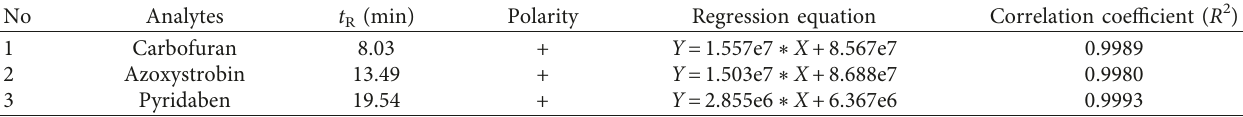
Table 4: Calibration curves and correlation of three representative analytes on the LC-Q-Exactive Focus Orbitrap MS. No Analytes t R (min) Polarity Regression equation Correlation coefficient ( R 2 )